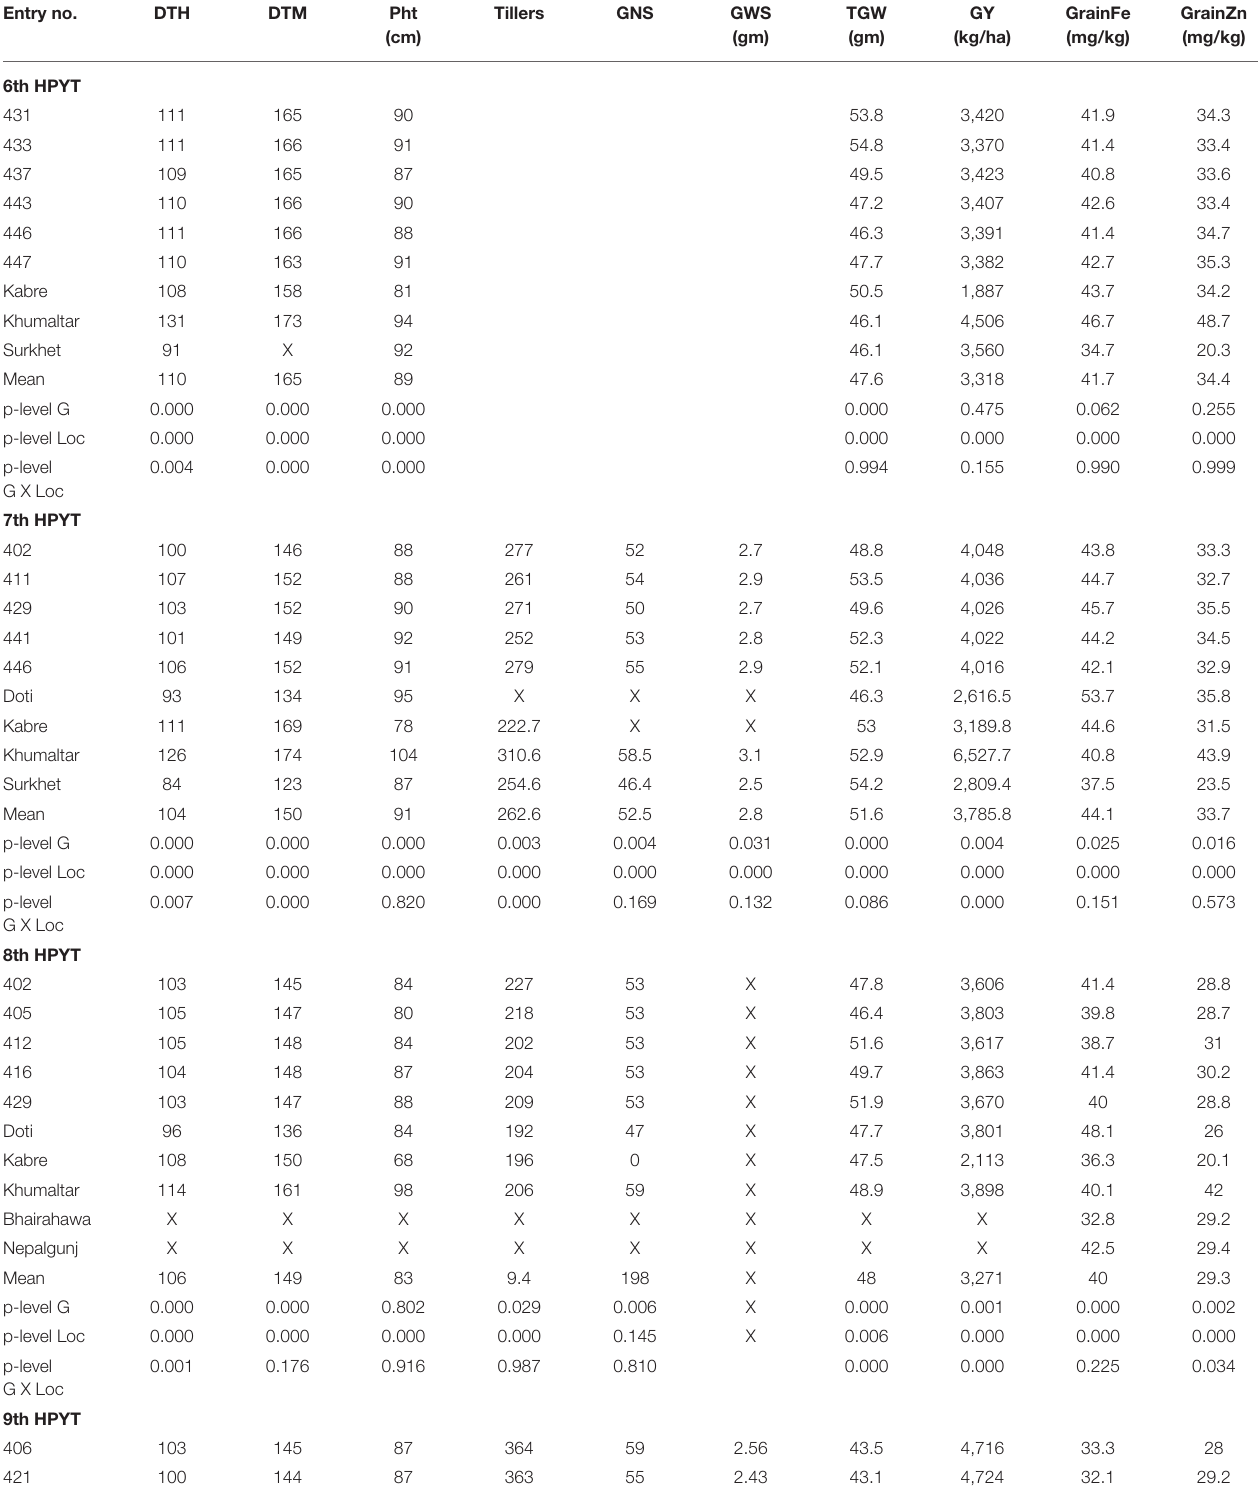
TABLE 1 | Top five high yielding lines from 6th, 7th, 8th and 9th HarvestPlus Yield Trial during 2015–16 to 2018–19 along with the mean value and ANOVA p-level statistics for corresponding traits calculated across all tested genotypes and locations in the respective years. Entry